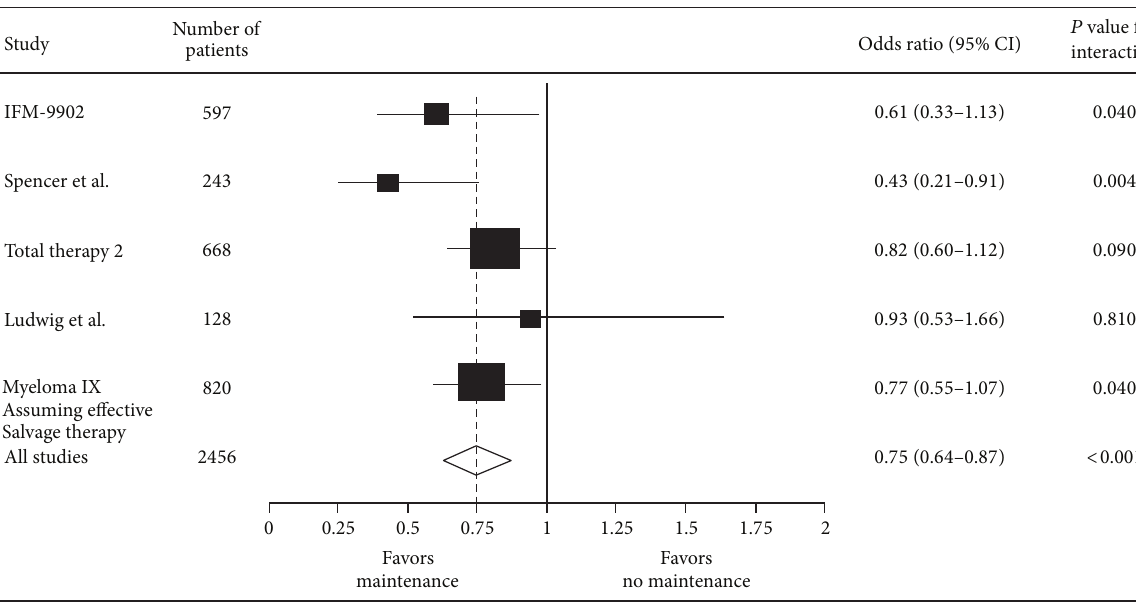
Figure 4: Collective data from thalidomide trials favoring maintenance (adapted from